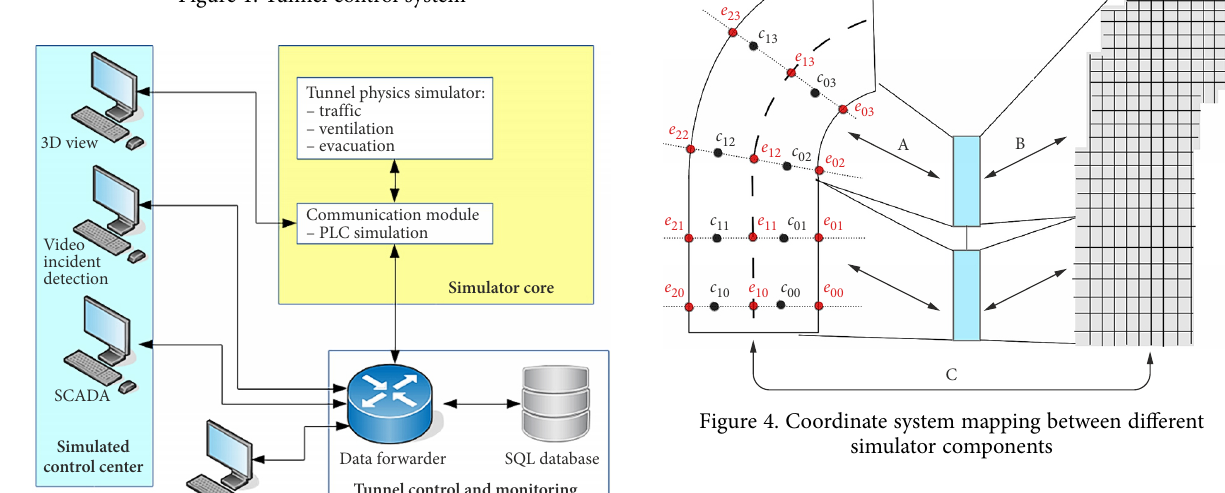
Figure 1. Tunnel control system